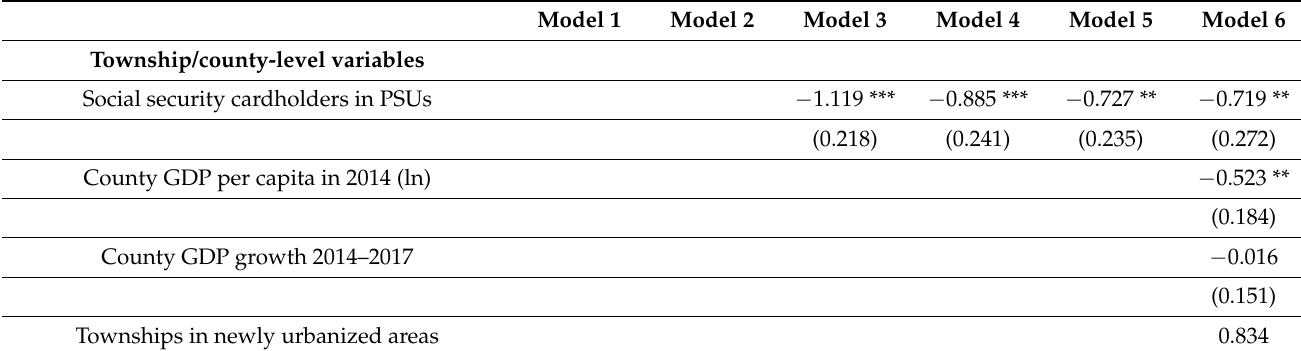
Table 3. Three-level mixed-effects models on psychological